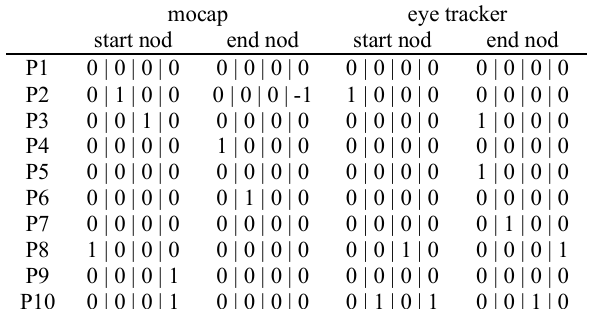
Table 2. Differences in frames between the computational sync points and the “ground truth data” of both mocap and eye tracker for all 40 recordings. One mocap frame equals 5 ms, while one eye tracker frame equals 20 ms.